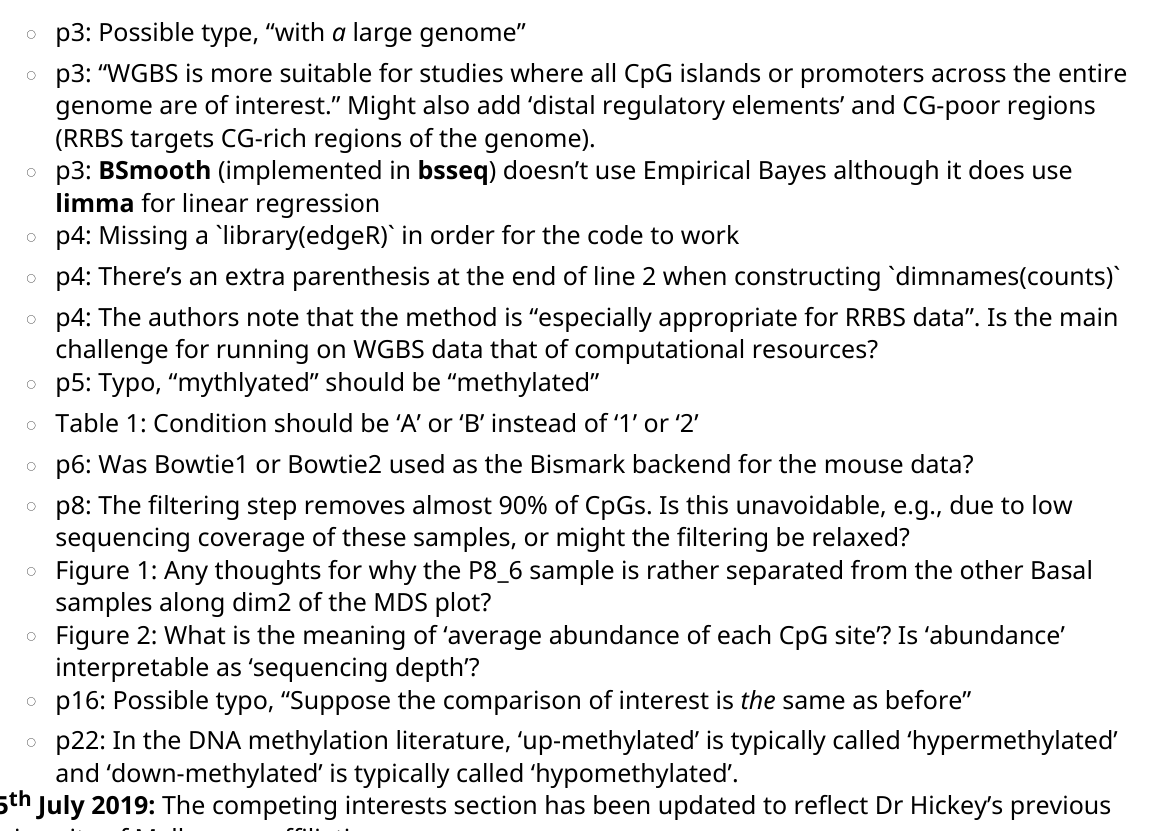
Figure 1: Any thoughts for why the P8_6 sample is rather separated from the other Basal samples along dim2 of the MDS plot? Figure 2: What is the meaning of ‘average abundance of each CpG site’? Is ‘abundance’ interpretable as ‘sequencing